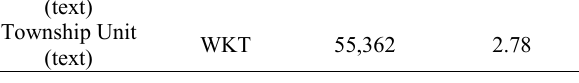
Table 2 . Land cover and township data statistics